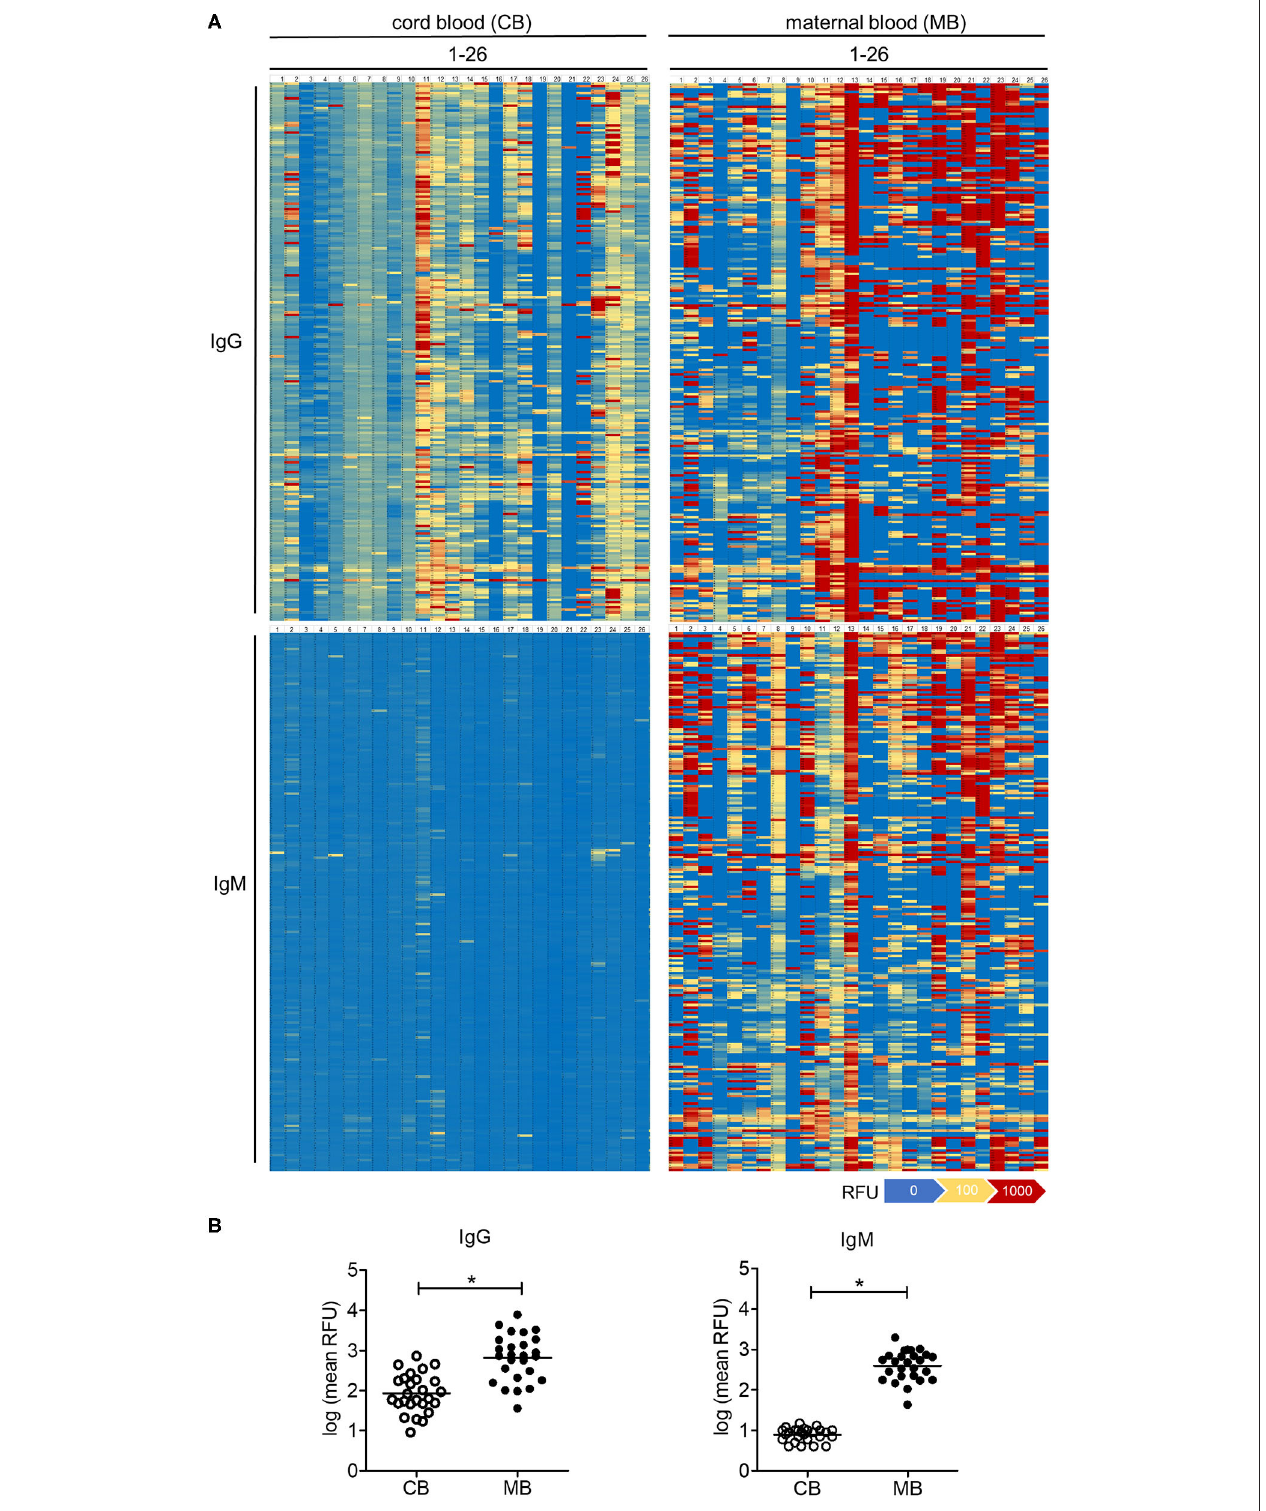
FIGURE 2 | Carbohydrate-specific IgG is lower in cord blood than in matched maternal blood, whereas carbohydrate-specific IgM is absent in cord blood. (A) Heatmaps of the serum IgG and IgM reactivity to 220 different glycans measured by glycan array analysis, displayed for 26 matched pairs of cord blood (CB1-26) and maternal blood (MB1-26). (B) Quantification of cord blood (CB) and maternal blood (MB) IgG and IgM reactivity to glycans measured by arrays. Results with p -value < 0.05 are marked with asterisks.